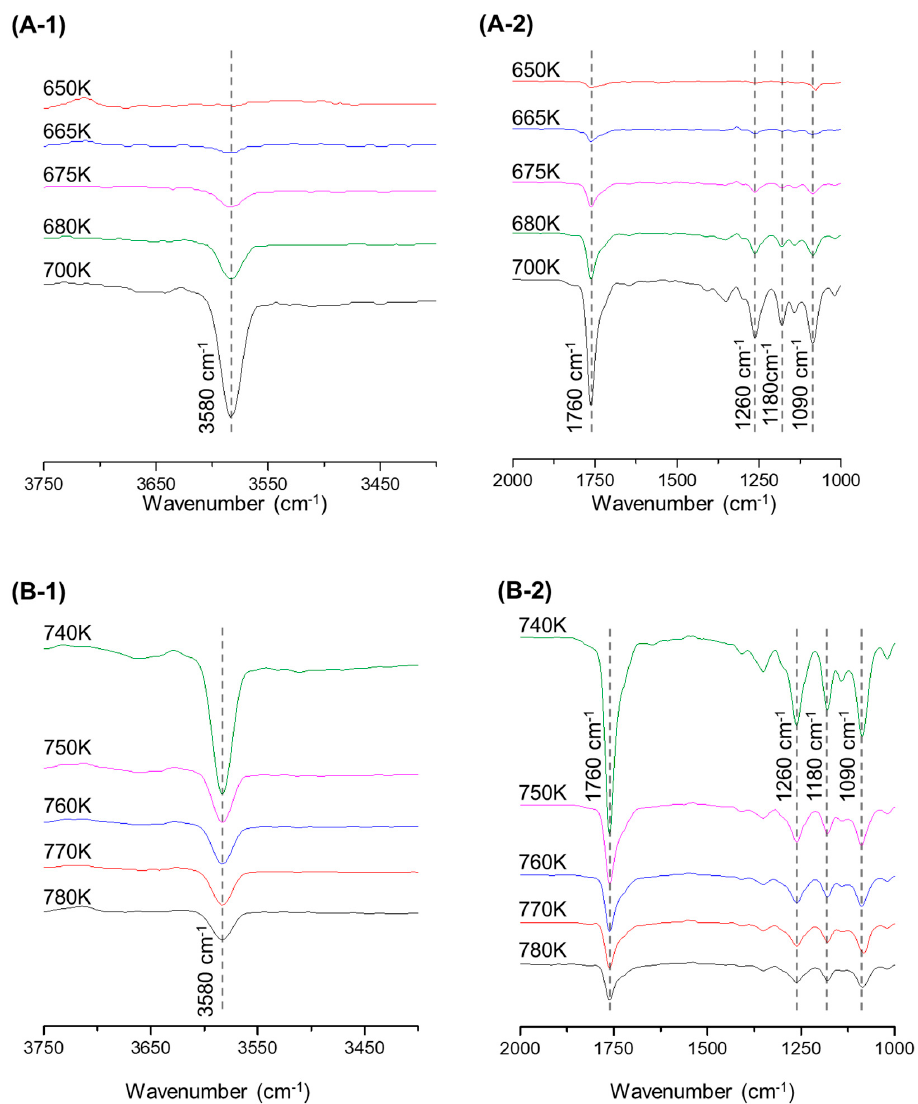
Figure 5. TG-FTIR spectrum drift by temperature during PET pyrolysis: ( A-1 ) 3750–3400 cm − 1 , in the range of 650–700 K; ( A-2 ) 2000–1000 cm − 1 , in the range of 650–700 K; ( B-1 ) 3750–3400 cm − 1 , in the range of 740–780 K; ( B-2 ) 2000–1000 cm − 1 , in the range of 740–780 K.